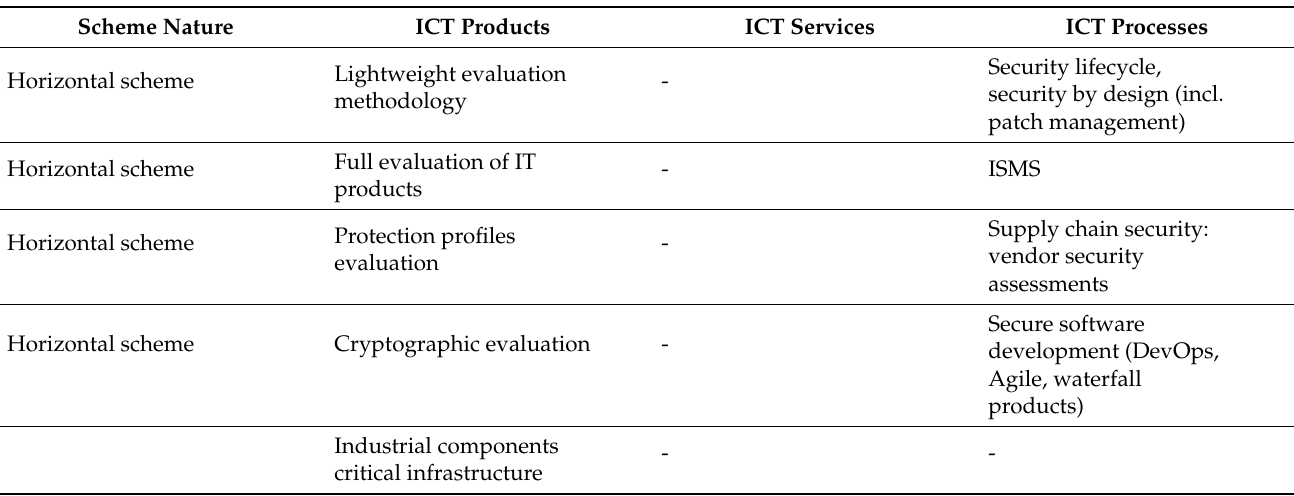
Table 1. Possible areas for future cybersecurity schemes according to the SCCG